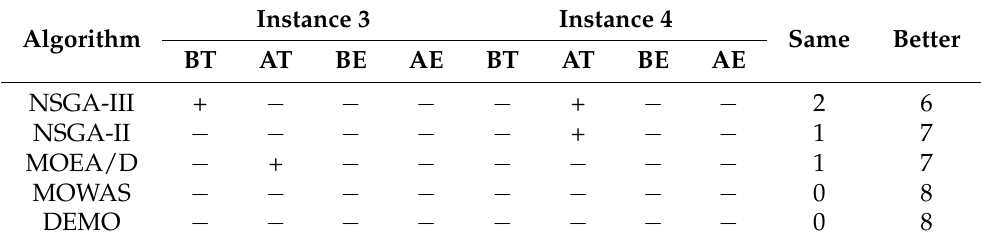
Table 14. The p values of APNSGA-III and other algorithms on Instance 3 and Instance